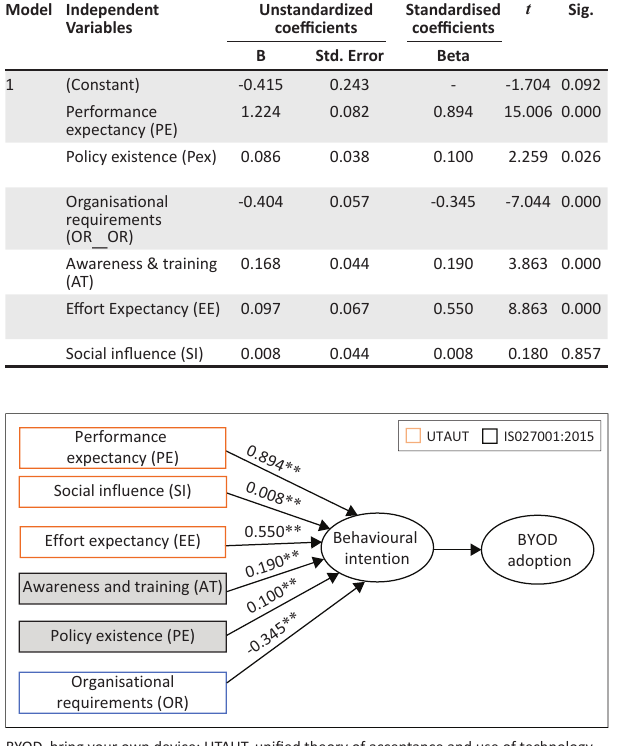
TABLE 3: Coefficients analysis. Model Independent